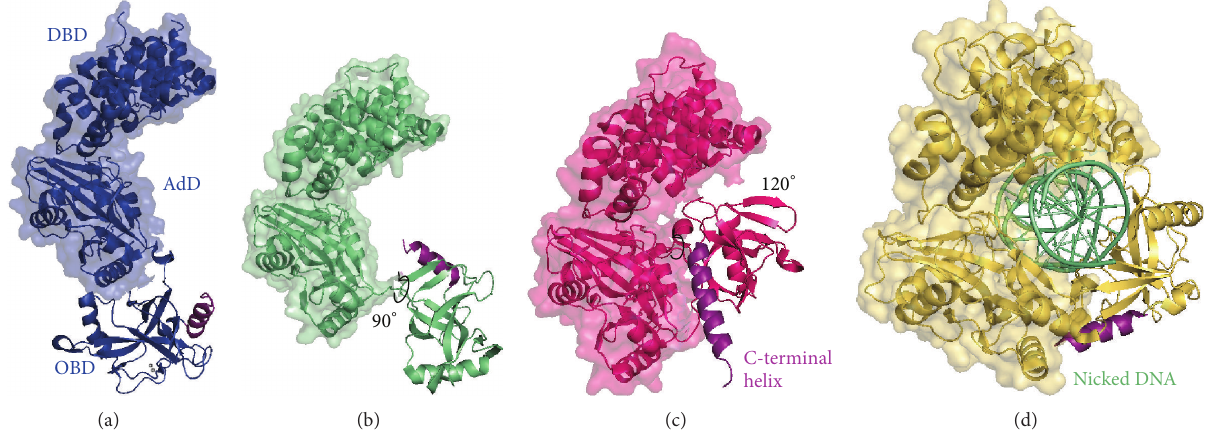
Figure 1: Structures of the DNA ligases from: (a) Sulfolobus solfataricus (PDB ID 2HIX); (b) Thermococcus sp. 1519 (PDB ID 3RR5); (c) Pyrococcusfuriosus (PDBID2CFM);and(d) Homosapiens (PDBID1X9N).ThepositionsoftheDNAbindingdomain(DBD),adenylation domain (AdD), and oligonucleotide binding domain (OBD) are indicated in the S. solfataricus structure. While the DBD and AdD occupy equivalent positions in all of the structures, the S. solfataricus enzyme shows an open extended conformation of the OBD, the Thermococcus sp. 1519 enzyme shows a 90 ∘ anticlockwise rotation of the OBD relative to the S. solfataricus enzyme (indicated by a black arrow) resulting in the intermediate conformation, and the P. furiosus ligase has a 120 ∘ rotation exhibiting the closed conformation. Human DNA ligase 1 is shown bound to a nicked DNA substrate (light green). The C-terminal helix of each enzyme is highlighted in purple.